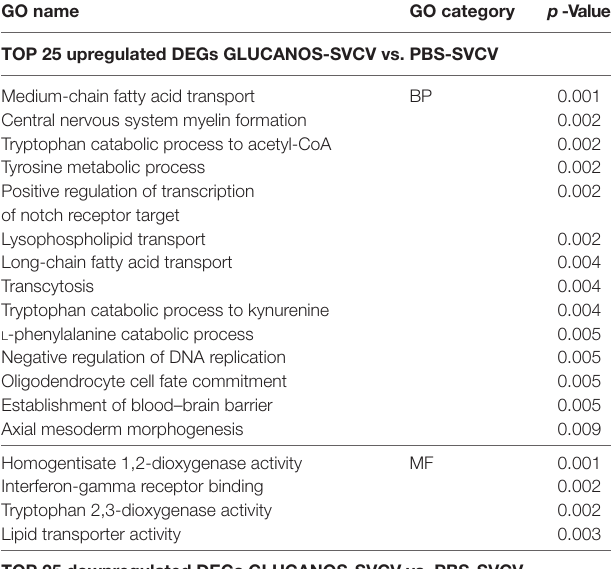
TaBle 2 | Gene ontology (GO) enrichment analysis of the top 25 most modulated genes in fish that previously received β -glucans and were then infected [Glucans-Spring Viremia Carp Virus (SVCV)] compared to untreated and infected fish